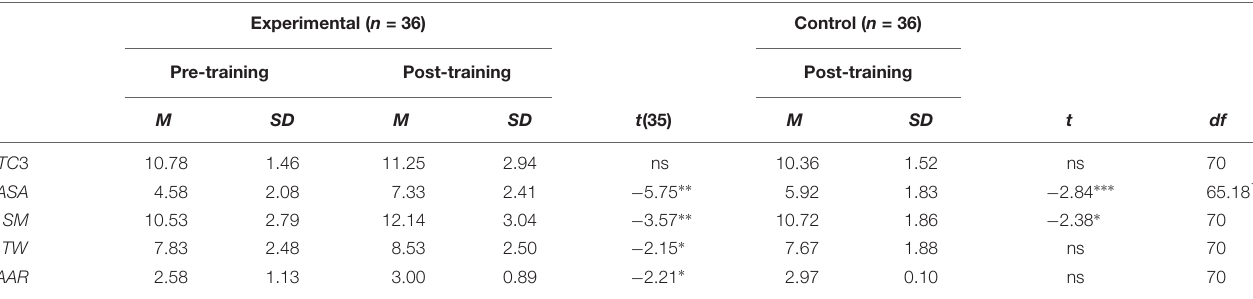
TABLE 2 | Changes in experimental condition pre- and post-training knowledge test scores, and comparison of experimental and control condition post-training knowledge test scores. Experimental ( n = 36) Control ( n =